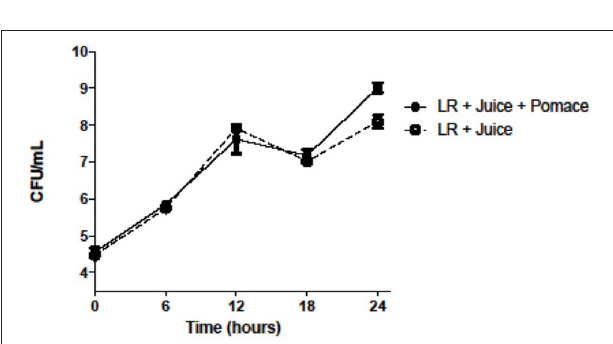
FIGURE 2 | Comparison of Lactobacillus rhamnosus (LR) viability during 24h fermentation of grape juice with and without grape pomace at 37 ◦ C.